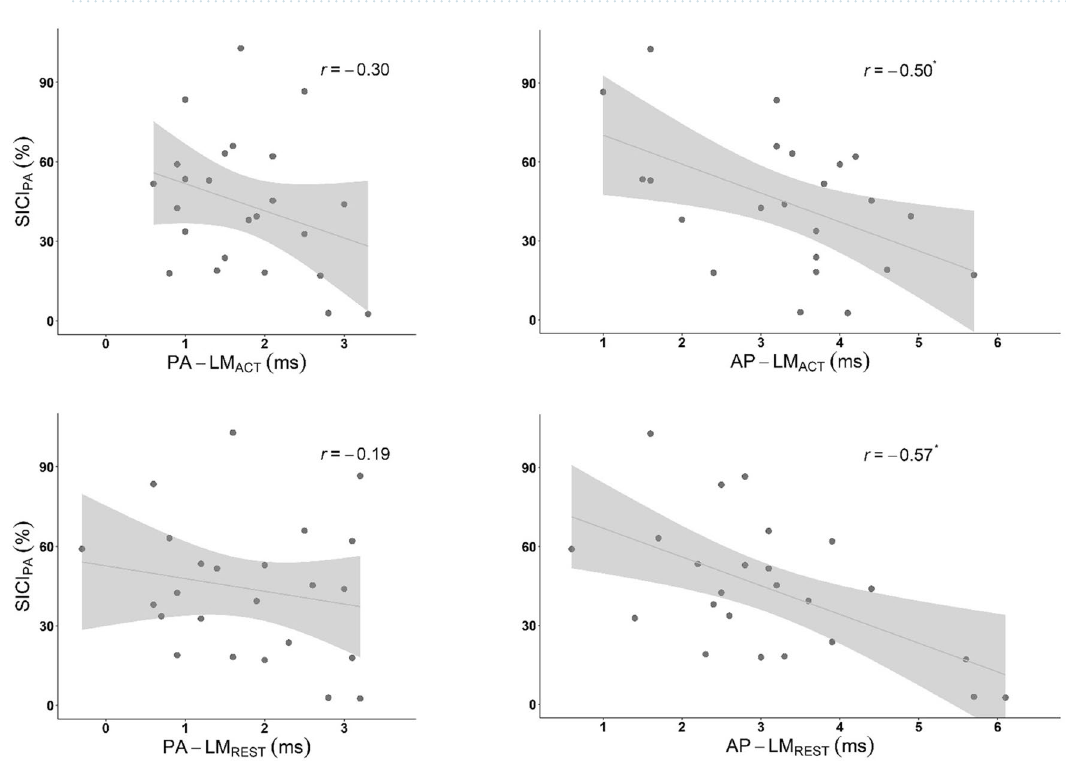
Figure 4. SICI PA and MEP latency. SICI (%), Short-Interval Intracortical Inhibition 100% = no inhibition, < 100% = inhibition; Latency Difference (ms), Individual PA and AP latencies subtract active LM latency; PA, posterior-anterior; AP, anterior–posterior; LM, latero-medial; r , Pearson’s correlation coefficient; Shaded area, 95% CI; * p adj <